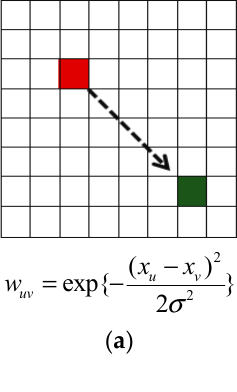
Figure 1. Comparison of node affinity to sub-graph affinity. x u (red), x v (green), P u (light red), P v (light green). ( a ) Node affinity. ( b ) Node affinity with neighborhood statistics. ( c ) Sub-graph affinity.